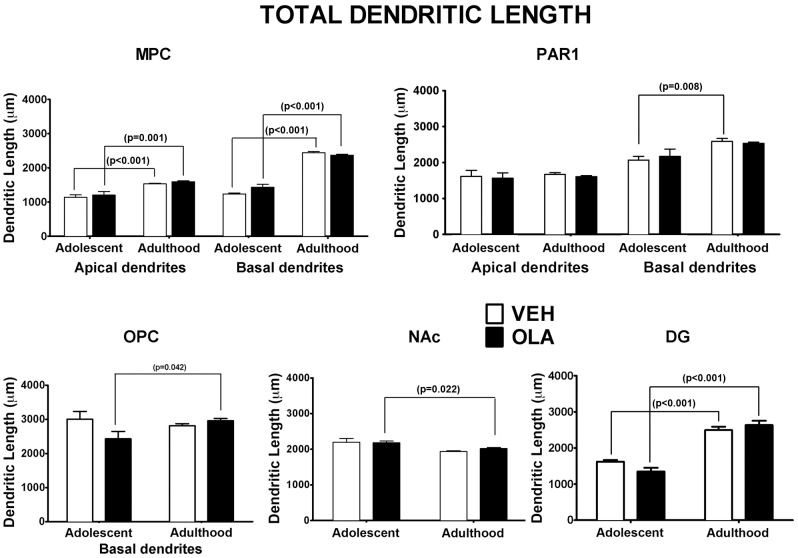
Total dendritic length.There were no statistically significant effects of treatment in adolescents or adults. p-values above brackets indicate the significance of age related changes. All p-values are based on paired t-tests corrected for multiple comparisons. Error bars are standard error of the mean.